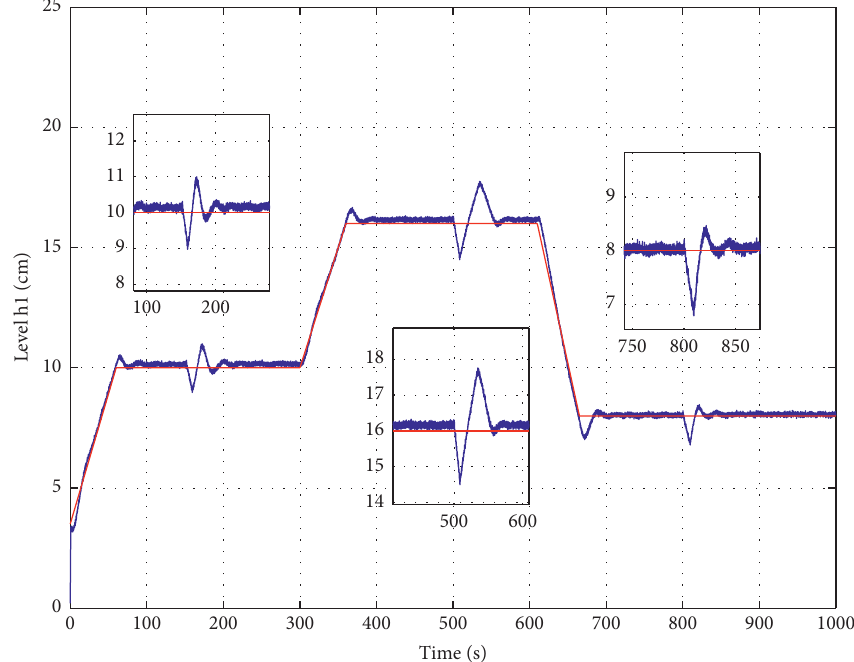
Figure 8: Experimental result for NTSMC tracking and its impact on parameter